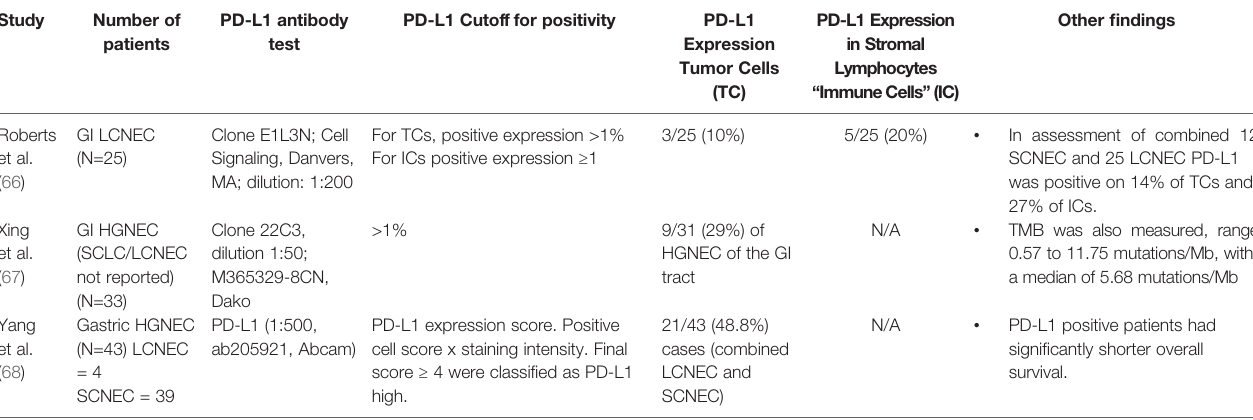
TABLE 4 | Key papers describing PD-L1 expression in gastrointestinal